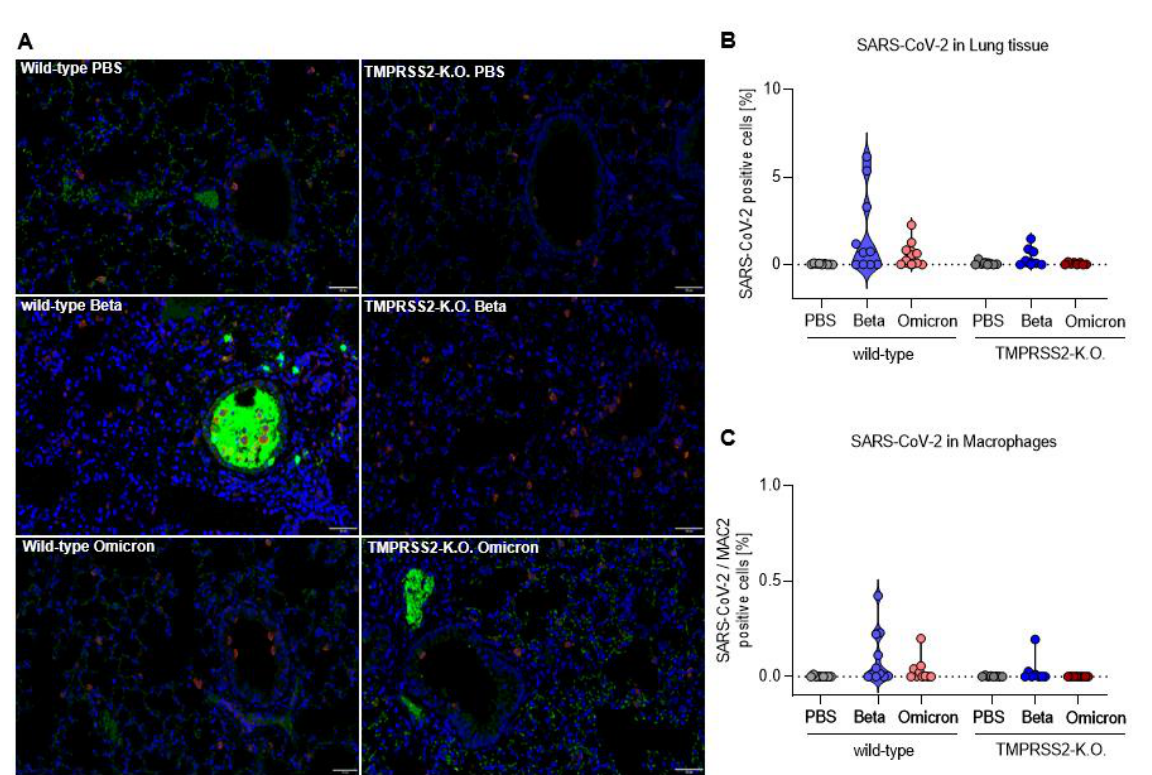
Figure 3. TMPRSS2 promotes lung cell infection by the SARS-CoV-2 Beta and Omicron variants. ( A ) Representative images of immunohistochemical staining for the Nucleocapsid CoV-1/2 (green) and MAC2 (magenta) in lung tissue of PBS (top), Beta (middle) and Omicron (bottom) infected wilt-type (left) and TMPRSS2 KO mice (right). All of the images were equally increased in brightness and contrast by the same absolute values. Scale bars, 50 µm. ( B ) Number of SARS-CoV-2 positive cells as a percentage of total cells counted. ( C ) Number of macrophages immunohistochemically stained for MAC2 that are concurrently positive for SARS-CoV-2 as a percentage.